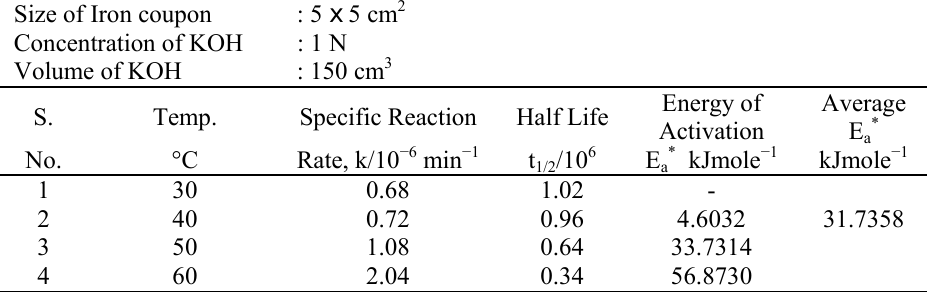
Table 3. Effect of temperature on corrosion rate in potassium hydroxide Size of Iron coupon : 5 x 5 cm 2 Concentration of KOH : 1 N Volume of KOH : 150 cm 3 S. Temp. Specific Reaction